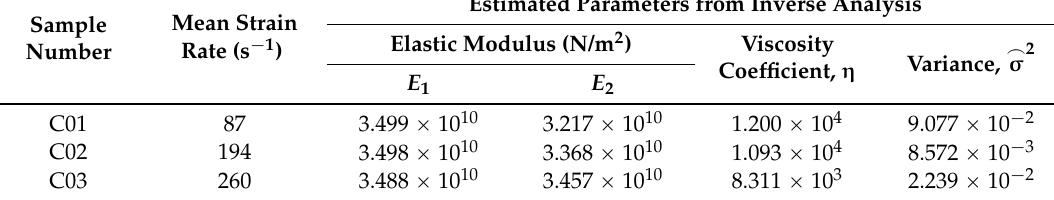
Figure 4. Schematic of the genetic algorithm (GA) used to determine parameters. Table 1. Inverse analysis of the parameters in the constitutive equations for viscoelastic-plastic rock-like